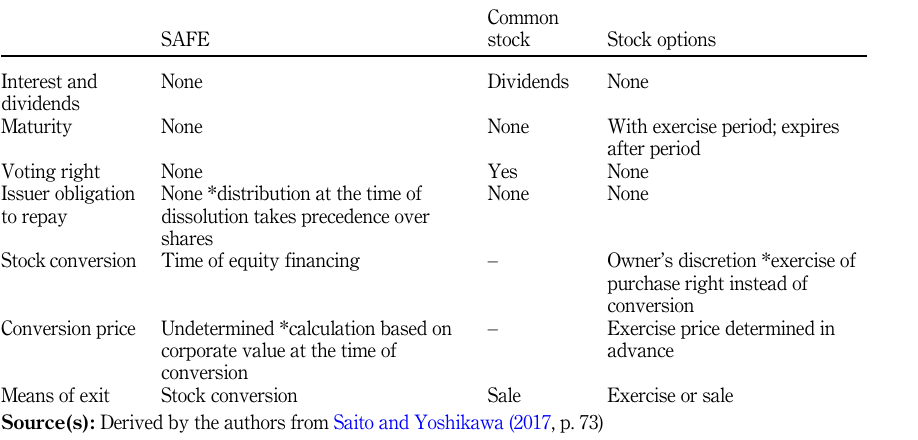
Table 1. Features of